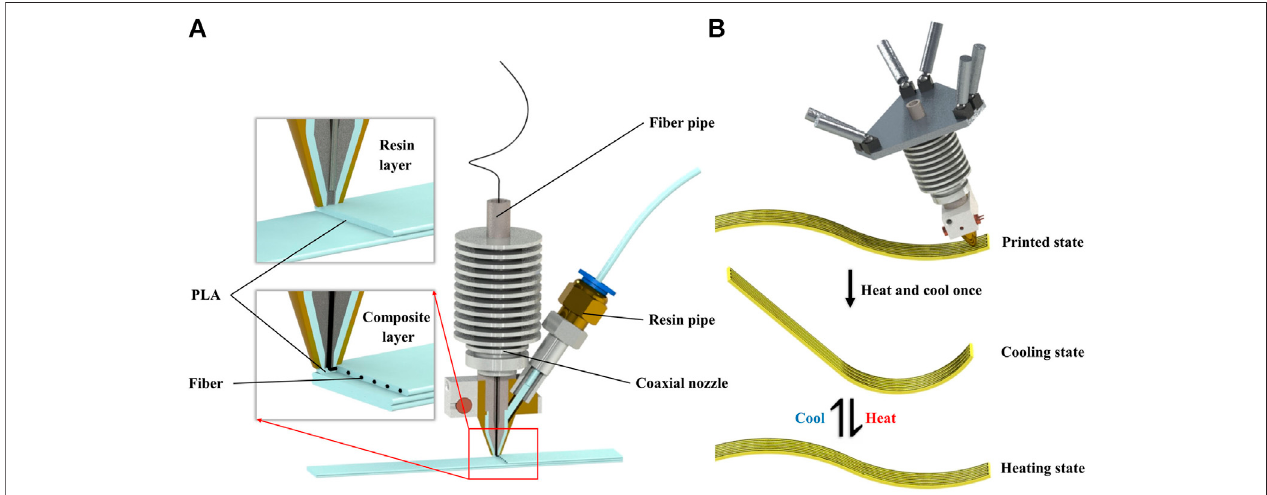
FIGURE1| 4Dprintedstructureconsistingofacompositelayerandaresinlayer. (A) Two-layerstructuremodelandprintingschematic. (B) Threedifferentstatesof 4D printed structure showing their transformations.